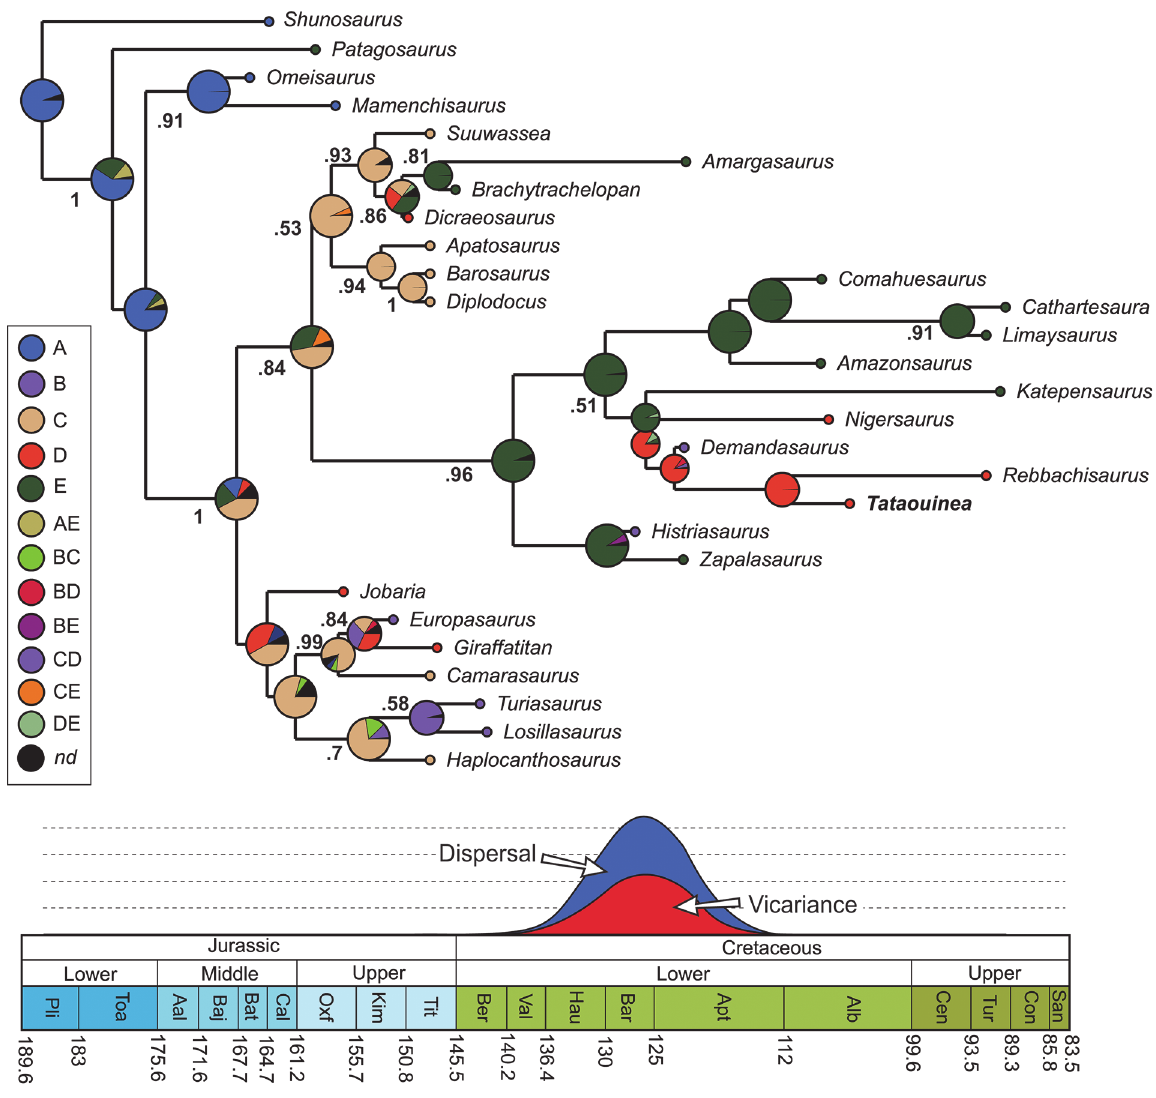
Fig 22. BBM palaeogeographyc analysis of Rebbachisauridae. Time-calibrated palaeobiogeography of eusauropods focusing on rebbachisaurids (above) and result of the time-event algorithm test on Rebbachisauridae (below), based on the BBM analysis of the MCCT recovered by Bayesian inference. Values at nodes indicate posterior probability values > 0.5. Abbreviations: A, Asia; B, Europe; C, North America; D, Africa; E, South America. Black circles indicate uncertain optimization.